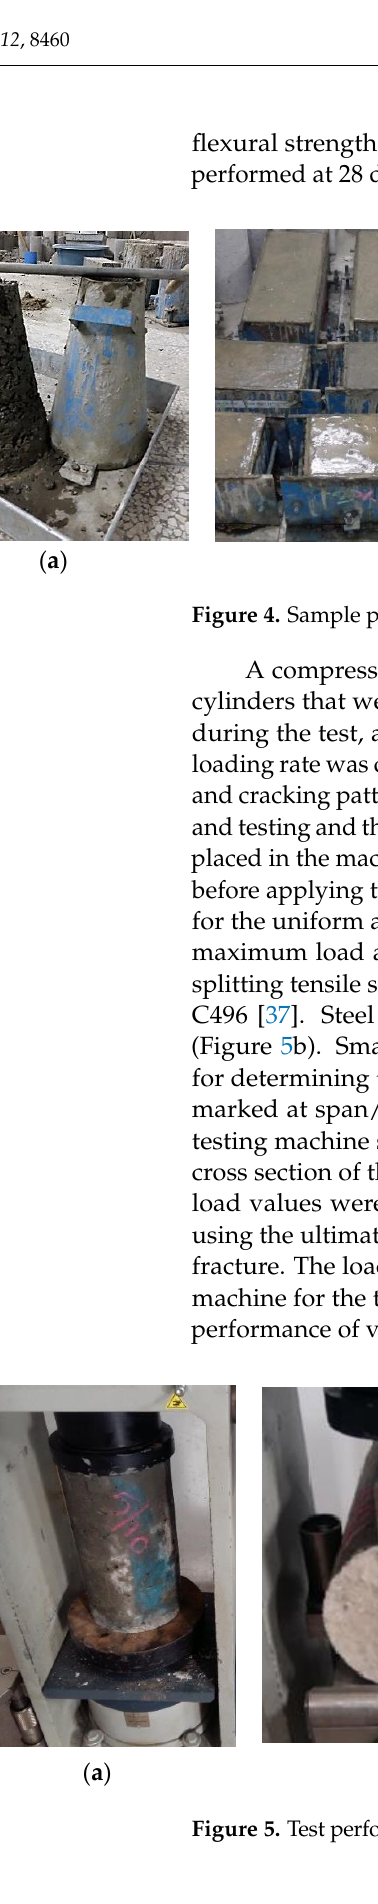
( b ) Figure 6. Impact test performance: ( a ) impact test setup, ( b ) placement of the specimen in the impact test apparatus. 4. Results and Discussion 4.1. Slump Flow Figure 7 shows the variation of the slump flow of fresh concrete incorporating vari- ous rubber sizes (R1, R5 and R10) and dosages (10%, 20% and 30%). It was observed that the workability reduced with increasing dosages of rubber. For instance, the mixture in- corporating R1 showed approximately 36%, 40% and 44% reductions in the slump for 10%, 20% and 30% dosages, respectively, compared to that of the similar mixture without the addition of rubber. This decrease in the slump with the higher dosage of rubber was